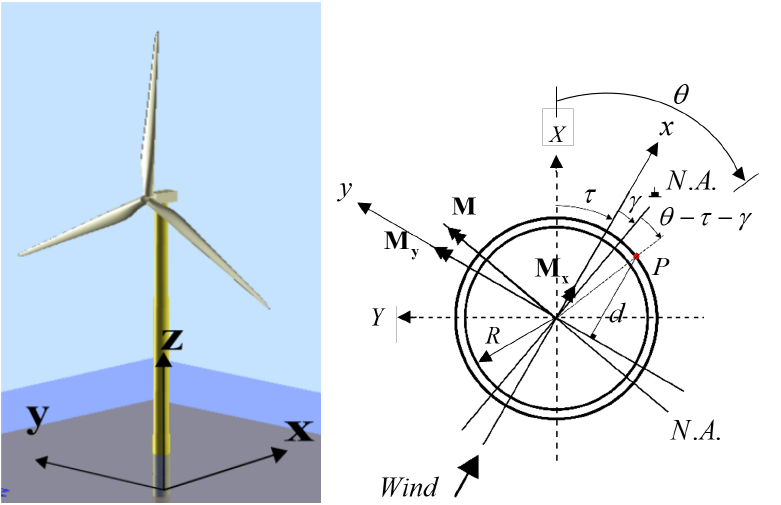
Figure 2. Wind turbine elevation co-ordinate system [18] ( left ), the tower co-ordinate system and cross section parameters as defined in this study ( right